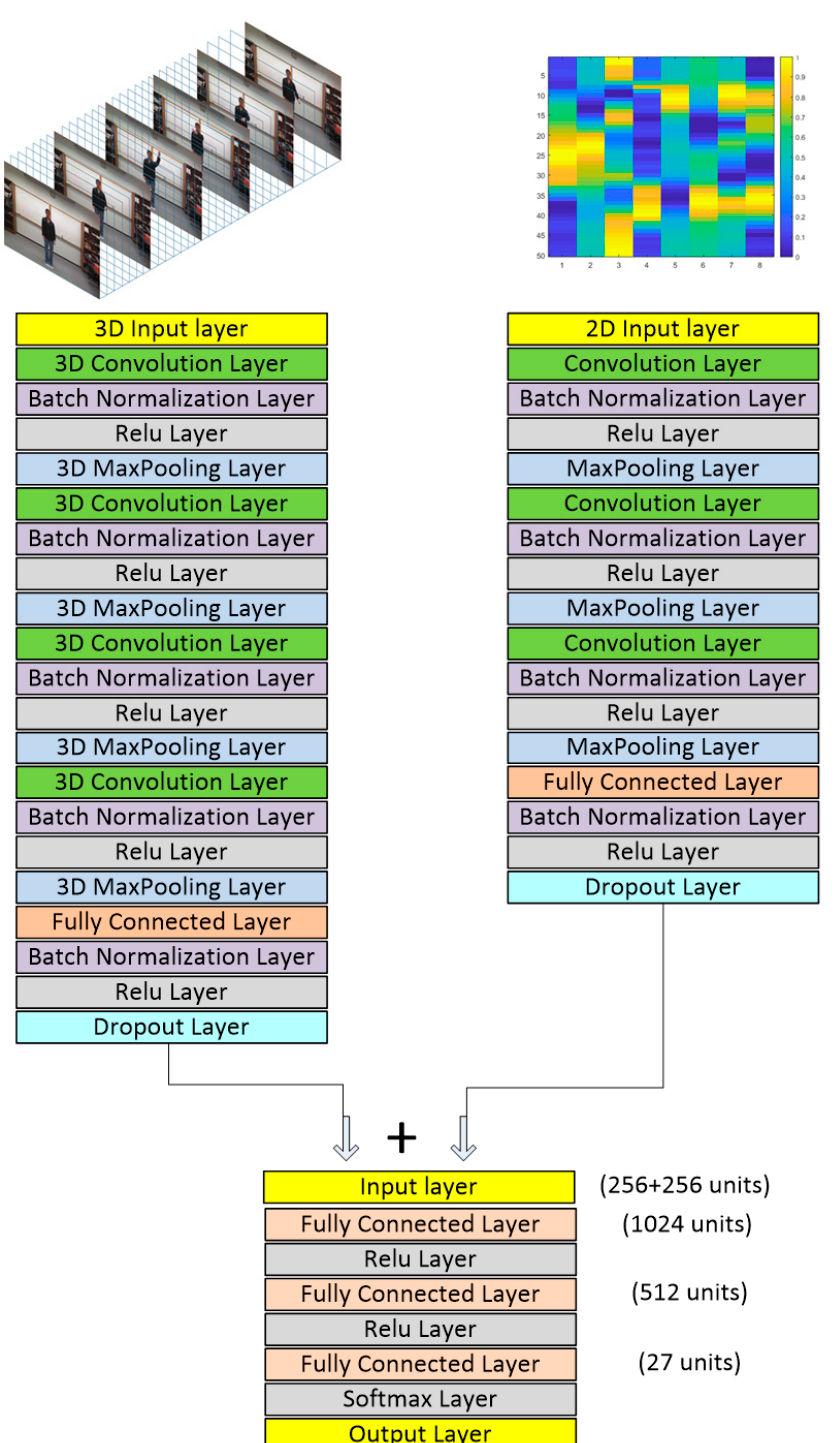
Figure 4. Network architecture used for the feature-level fusion of video and inertial sensing modalities.